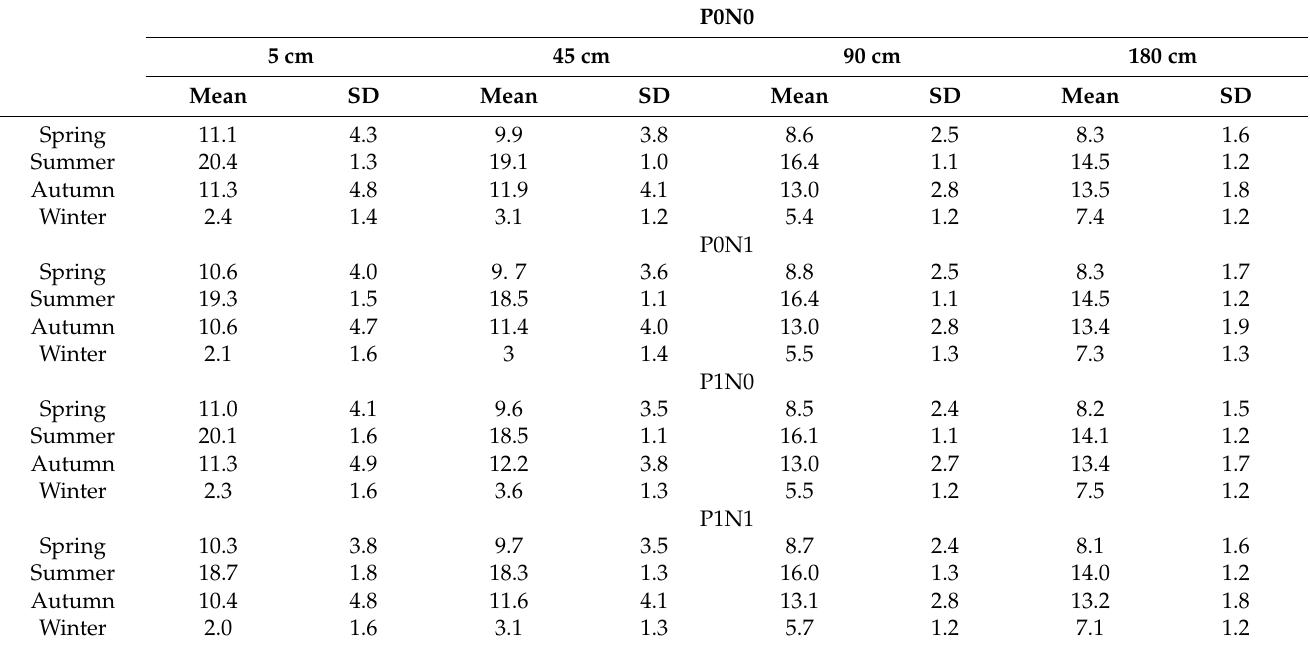
Table 6. Information of seasonal soil temperature under different treatments at different soil depths over the studied